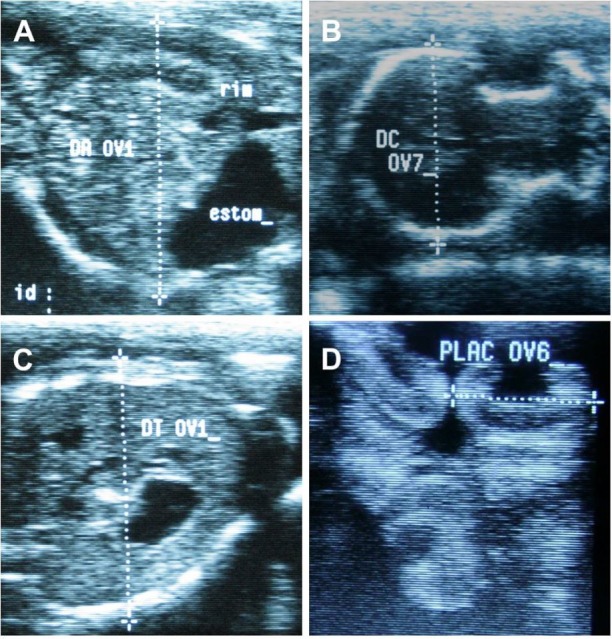
Ovine fetal biometry by B-mode ultrasonography. (A) Fetal abdomen transversely. (B) Biparietal diameter at the highest point between the parietal lobes. (C) thoracic diameter transversally at the level of the last rib. (D) placentome in longitudinal section.